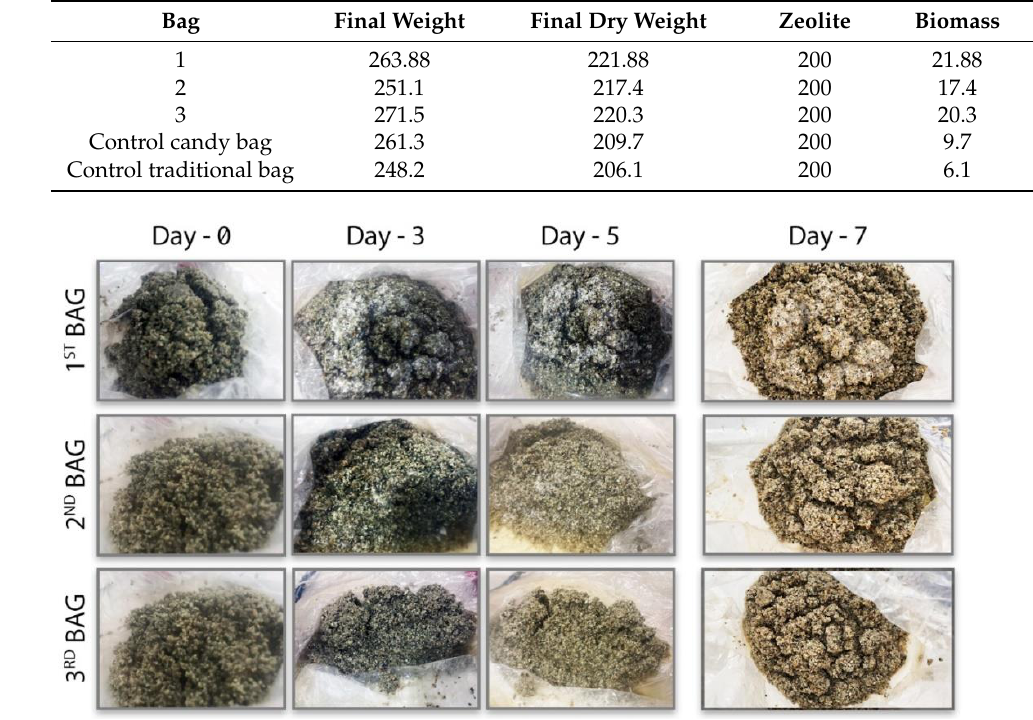
Figure 8. MCB biomass experiment observations.